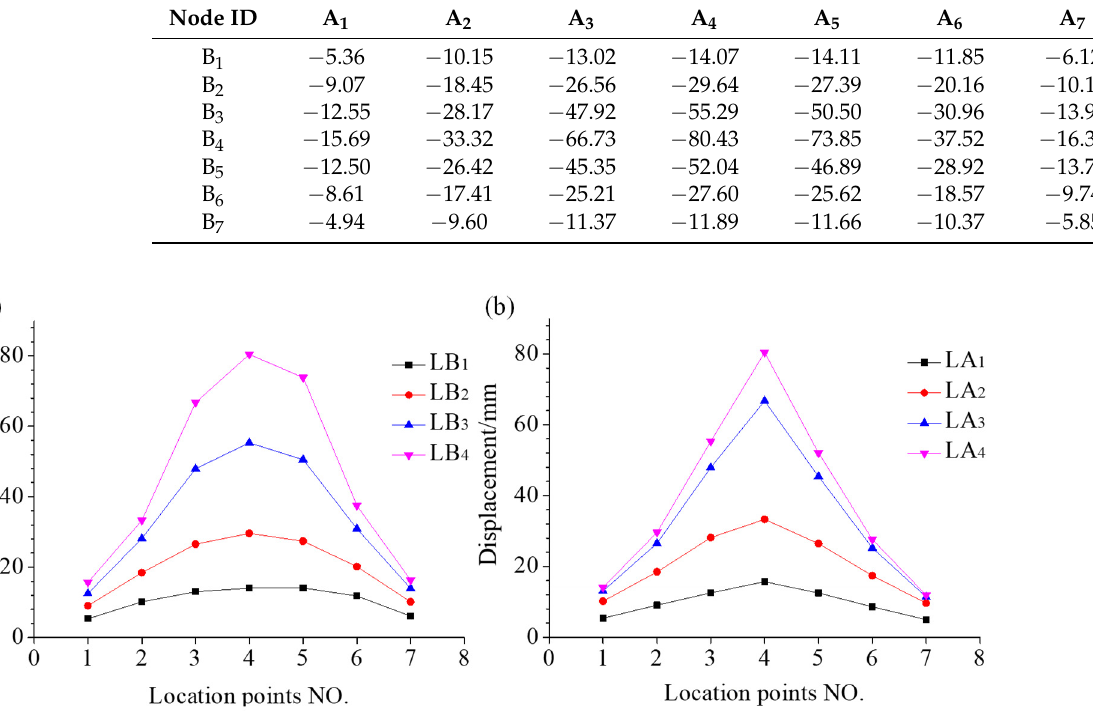
Figure 11. Plastic deformation of stiffened panel at typical locations: ( a ) Line Ai (LA, measuring points perpendicular to the stiffeners); ( b ) Line Bi (LB, measuring points parallel to the stiffeners).